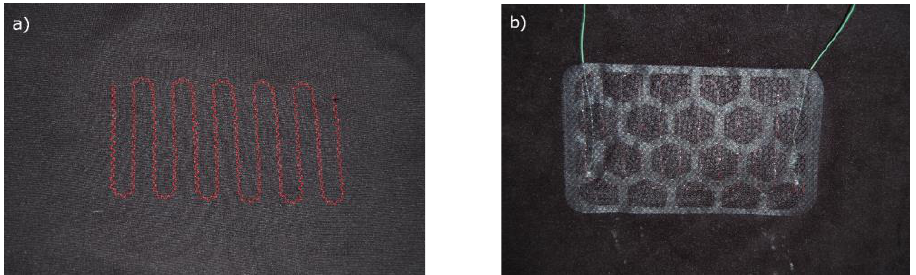
Figure 8. Photographs of the heating insert (variant B) after 9000 cycles of bending and twisting — outer surface ( a ) and inner surface ( b ).